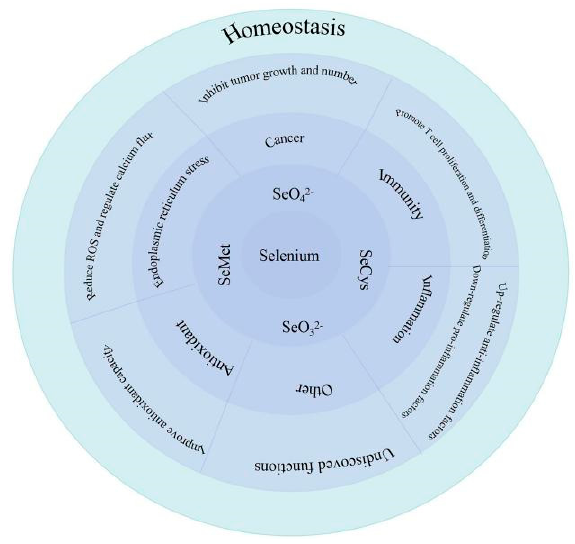
Figure 1. Biological role of Se.